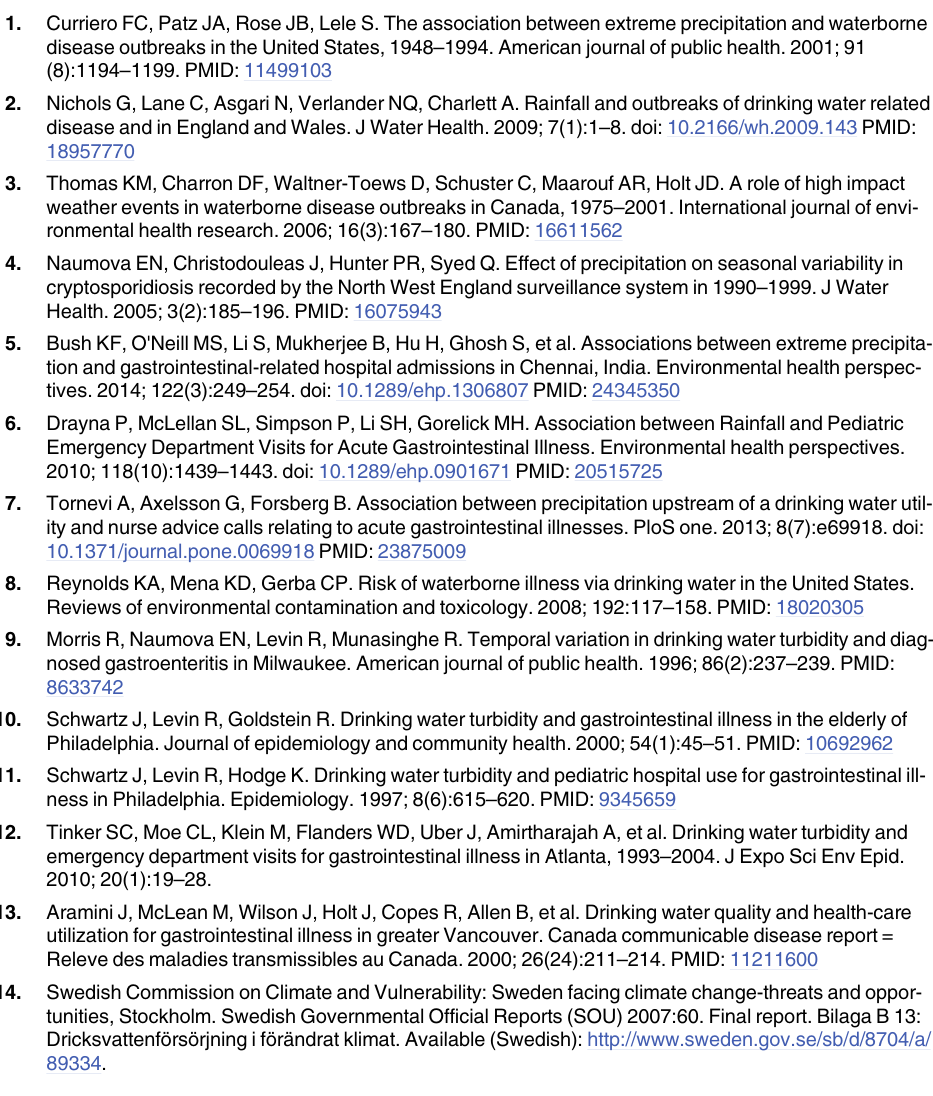
S2 Table. ICD codes. Number of cases diagnosed with ICD A00-A09 in the period 2007 – 2012, City of Gothenburg,